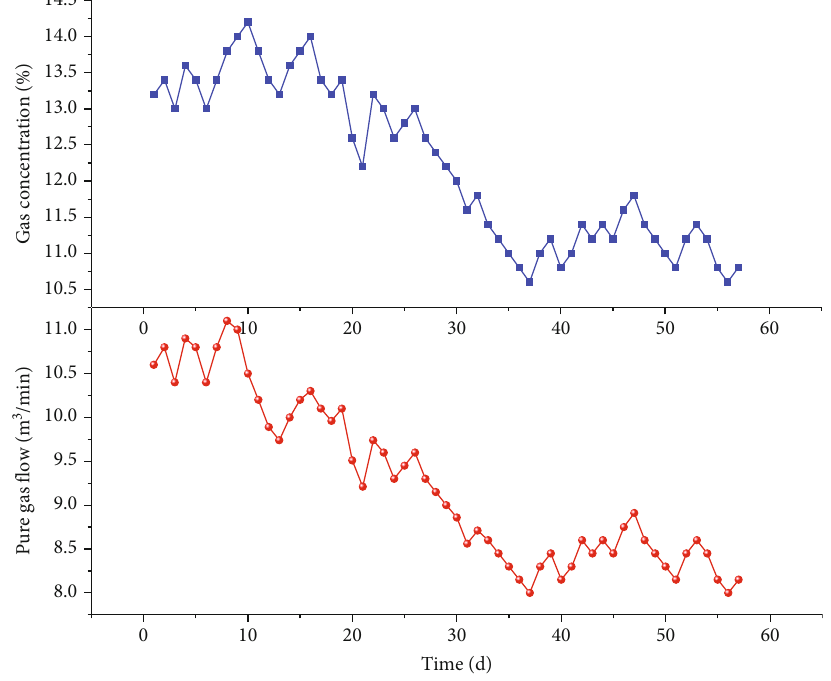
Figure 5: 2606 roadway gas concentration and pure gas fl ow